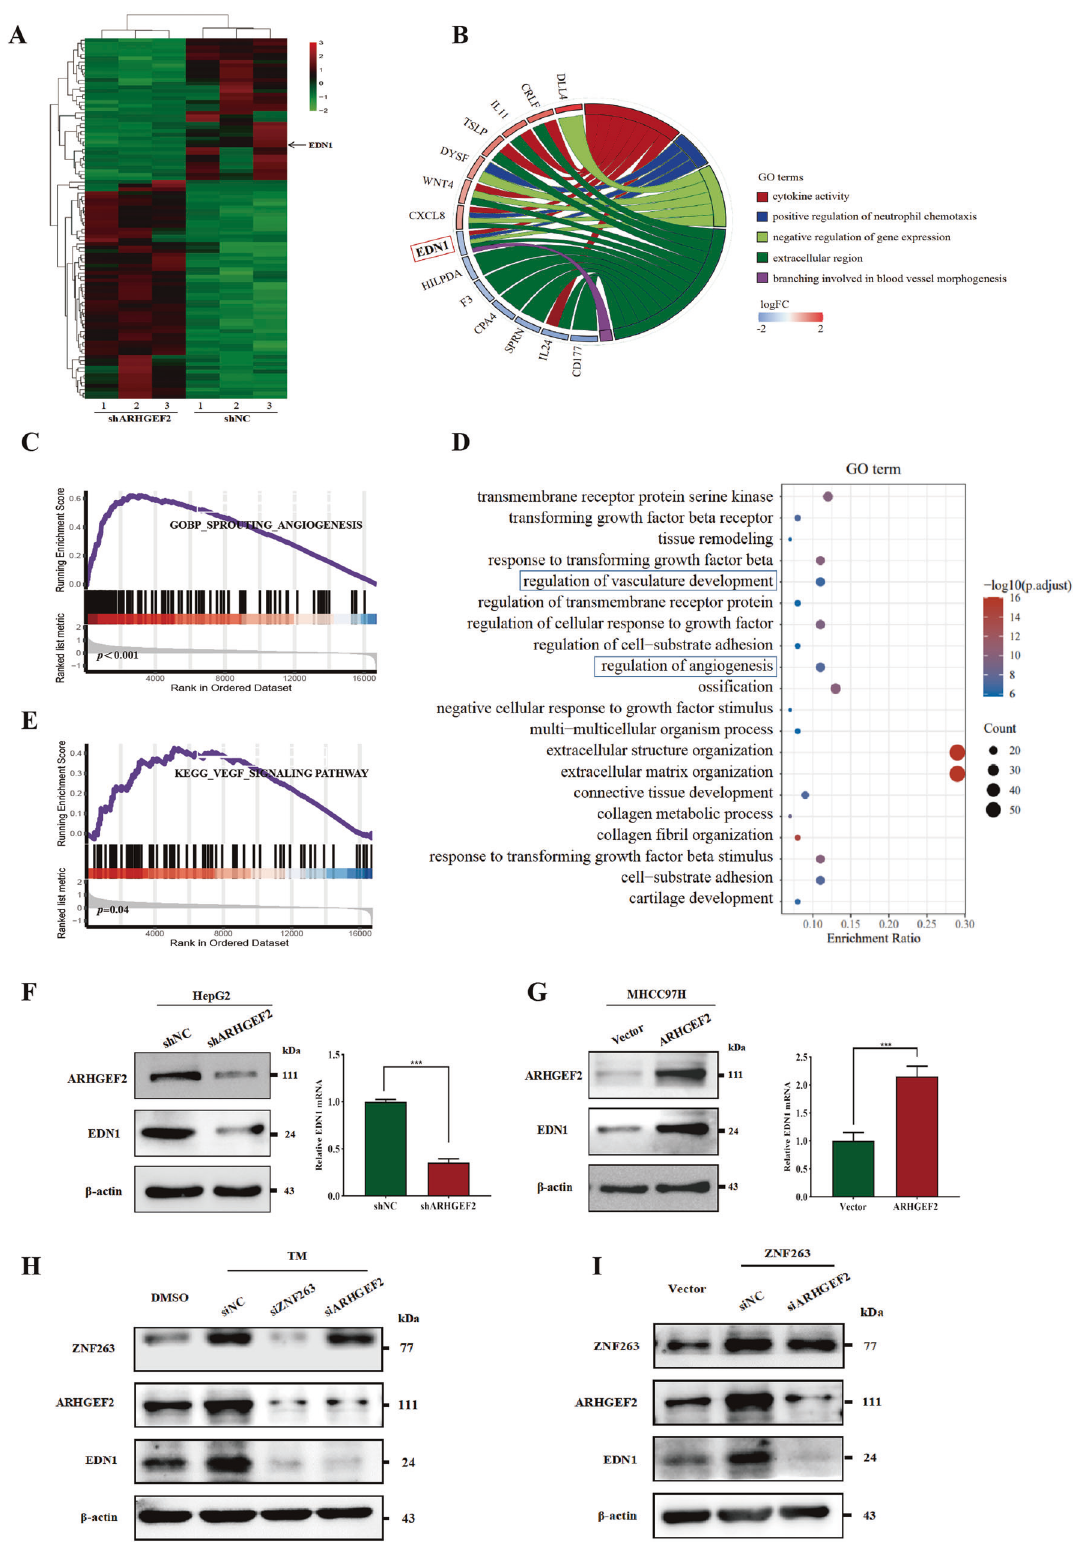
Fig. 7 EDN1 was the downstream effector of ARHGEF2. A Heatmap of the differentially expressed genes after ARHGEF2 knocked down in the HepG2 cells. B The chord diagram was plotted by GO enrichment analysis. C GSEA plot, demonstrating a signi fi cant correlation between the EDN1 expression levels and sprouting angiogenesis from published datasets. D Go enrichment analysis revealed the EDN1-associated signaling pathways (TCGA). E A GESA plot regarding the correlation between EDN1 expression and the VEGF signaling pathway. F The effect of ARHGEF2 knockdown on EDN1 protein and mRNA level were examined by Western blot and qRT-PCR in HepG2 cell lines. G EDN1 protein and mRNA level after ARHGEF2 overexpression were detected in MHCC97H cell lines. H Western blot was used to detect EDN1 levels after ZNF263 and ARHGEF2 were knocked down under ER stress. I EDN1 levels were examined after ARHGEF2 knockdown in ZNF263 overexpressing cell